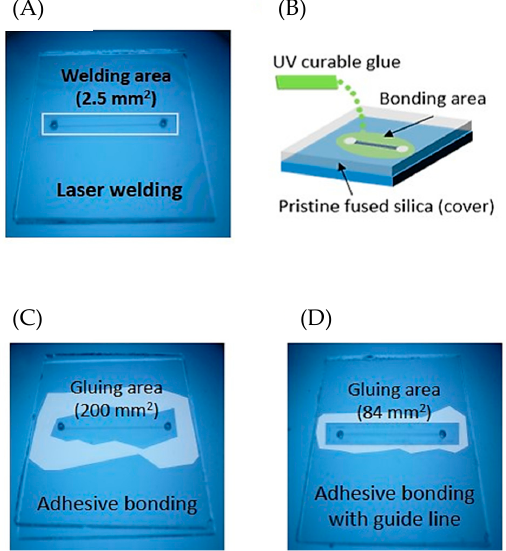
Figure 4. ( A ) Glass microfluidic device welded using the laser. The welding line (white line) was found around the microchannel. ( B ) Schematic of the ultraviolet (UV) curable glue application to bond two glass sheets. ( C , D ) Glass microfluidic devices bonded using UV curable glue. The left one had larger gluing area (200 mm 2 ) than the right (84 mm 2 ).